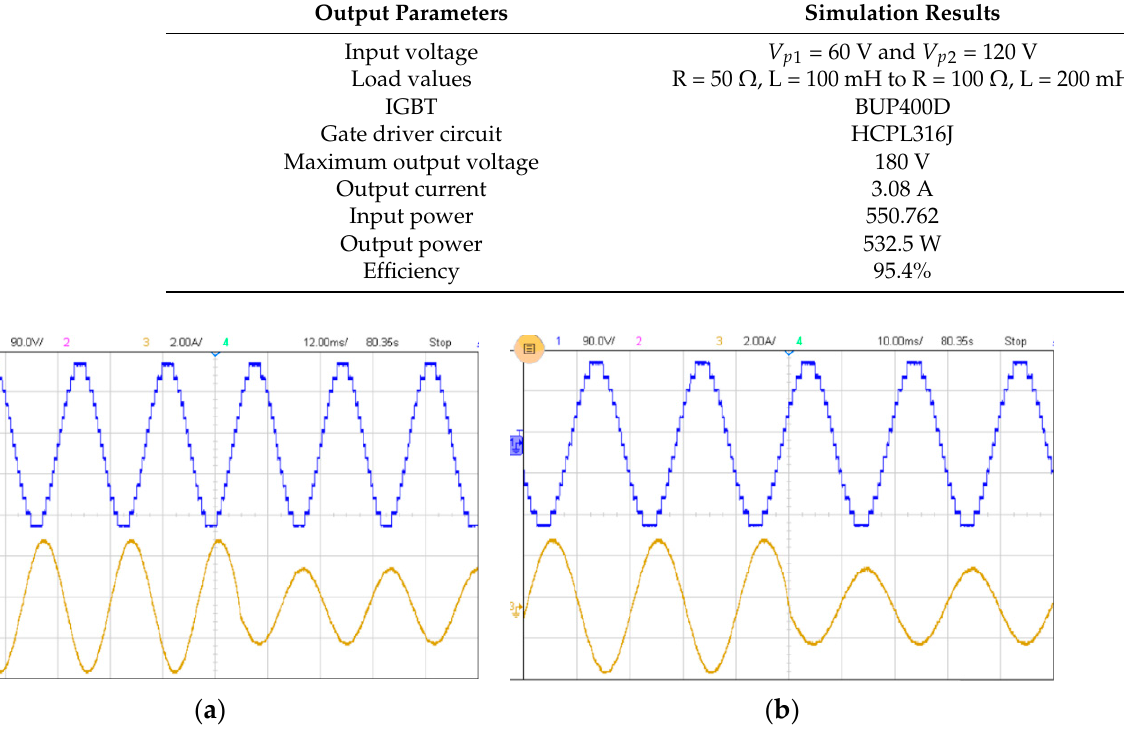
( b ) Figure 13. Experimental results ( a ) for highly inductive load and ( b ) zoomed view of load changes. In Figure 12a, the output voltage and current waveform of the proposed topology are observed with the balancing load circuit. The effect of the load change on load voltage and current are indicated in Figure 12b. When the load value is changing from the R = 50 Ω , L = 100 mH to R = 100 Ω , and L = 200 mH, the output voltage waveform remains the same, and the load current is instantaneously changed at the initial time of load transi- tion. However, the output current waveform is near the sinusoidal waveform, as shown in Figure 13a, and its zoomed view is depicted in Figure 13b.